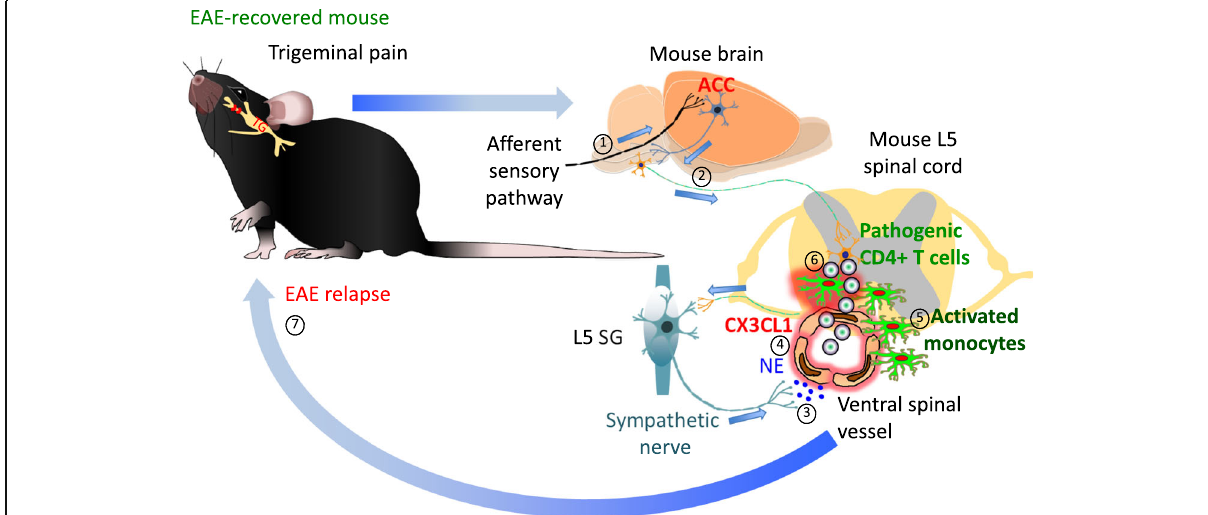
Fig. 3 Pain gateway reflex. In a transfer EAE-recovered mouse, induction of trigeminal pain by ligation of the infraorbital sensory nerve causes EAE relapse. In this condition, pathway carrying nociceptive information activates the ACC (1), a pain-processing area of the brain, which in turn stimulates sympathetic centers (2) and their neural output to the ventral spinal vessels (3). NE release around these vessels induces chemokine CX3CL1 expression from activated monocytes and endothelial cells (4). CX3CL1 recruits these activated monocytes around the ventral vessels in an autocrine/paracrine manner (5). Because the L5 spinal cord contains a high number of activated monocytes in EAE-recovered mice, the L5 region is most affected in terms of the accumulation of activated monocytes. Activated monocytes present MOG antigens to reactivate circulating pathogenic CD4+ T cells (6), thus causing their accumulation in the spinal cord and EAE relapse (7). Abbreviations: EAE, experimental autoimmune encephalomyelitis; ACC, anterior cingulate cortex; NE, norepinephrine; MOG, myelin oligodendrocyte glycoprotein; TG, trigeminal